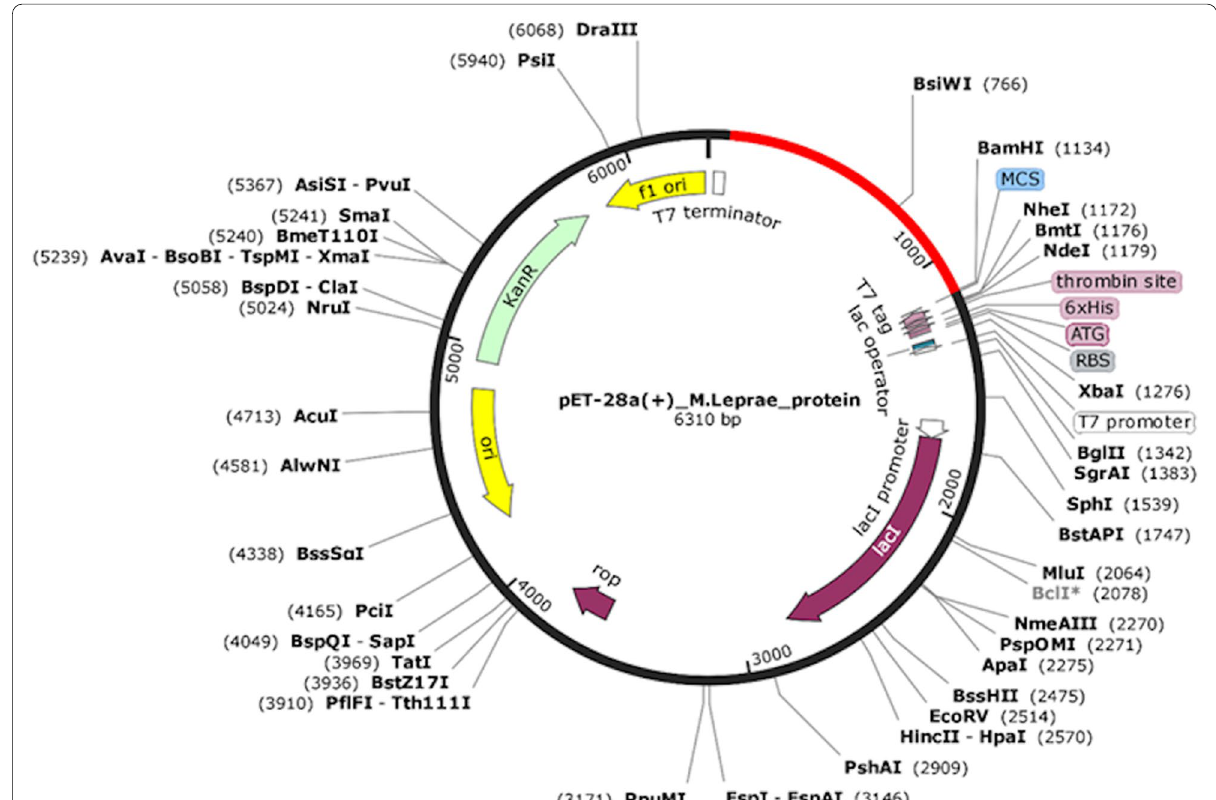
Fig. 3 In silico cloning. The recombinant multi‑epitope DNA sequence cloned into the pET28a( color. The insert was added between the BipI and BamHI restriction